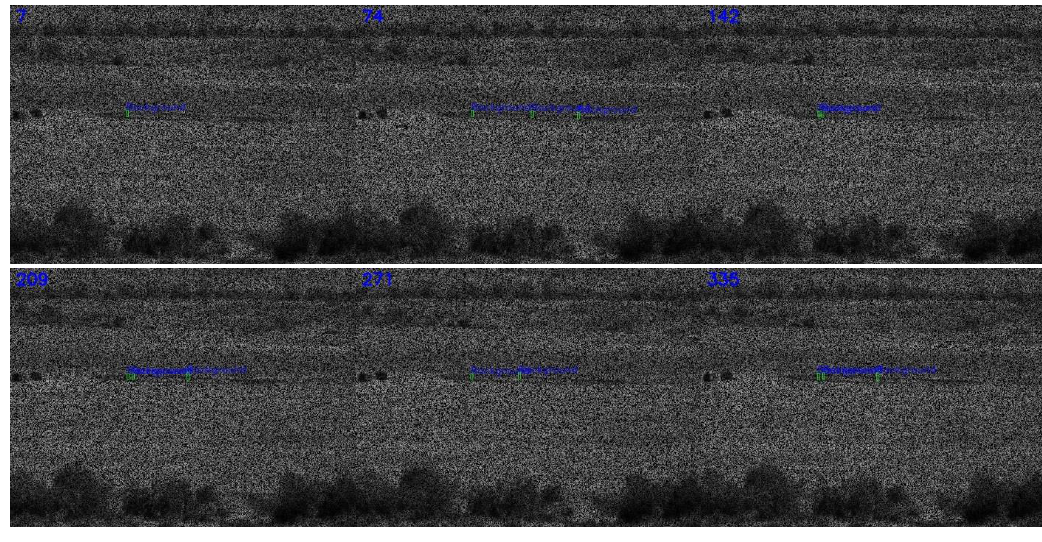
Figure 4. Detection results using optical coded aperture in PCE/CA 50% mode (50% missing). CA, coded aperture.